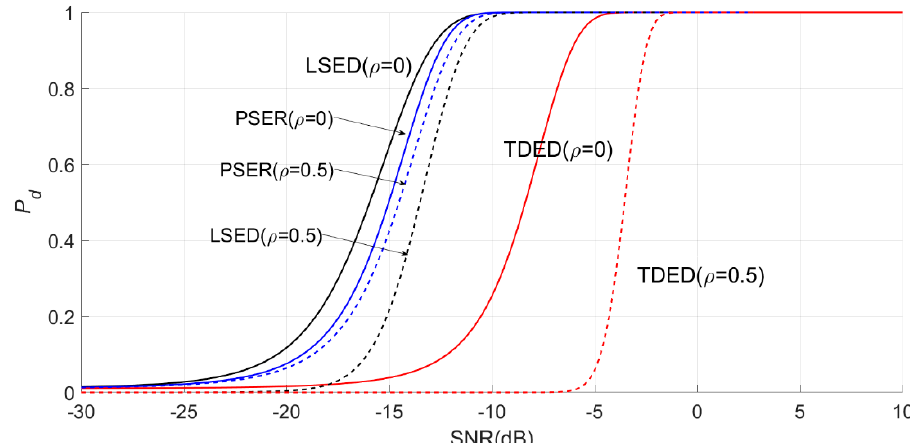
Figure 8. Effects of noise uncertainty on the PSER, LSED, and time-domain energy detection (TDED), where ρ = 0.5.